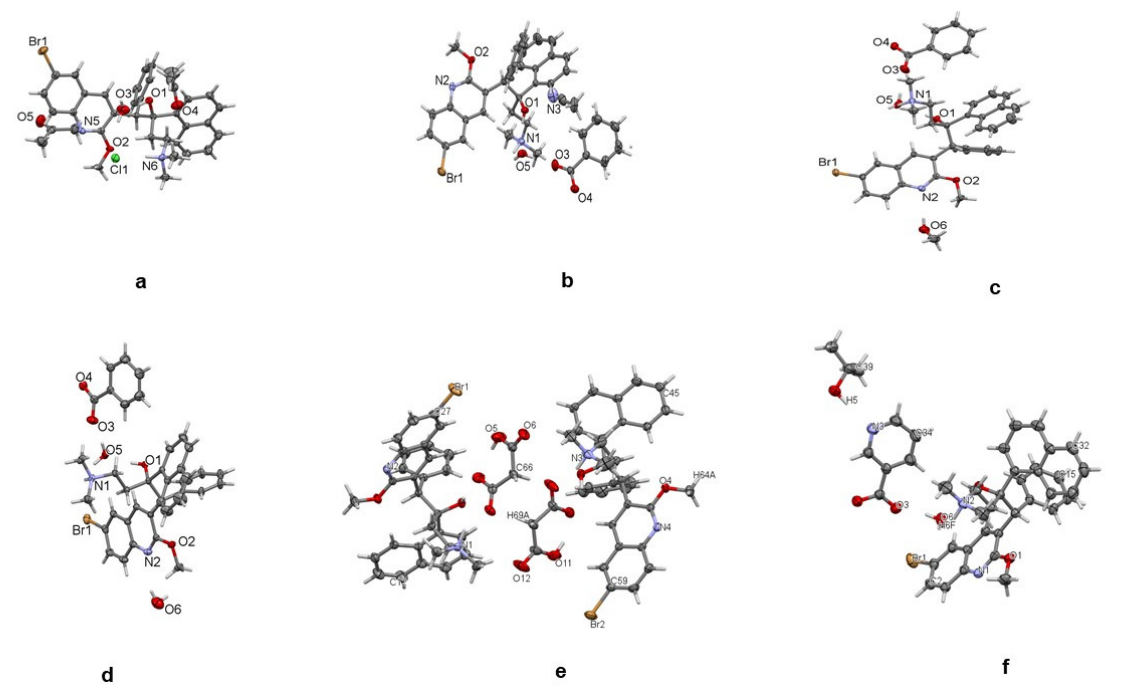
Figure 1. Single crystals of bedaquiline salts. ( a ) HCl, ( b ) benzoate acetonitrile solvate, ( c ) benzoate methanol solvate, ( d ) benzoate hydrate, ( e ) malonate, ( f ) nicotinate.